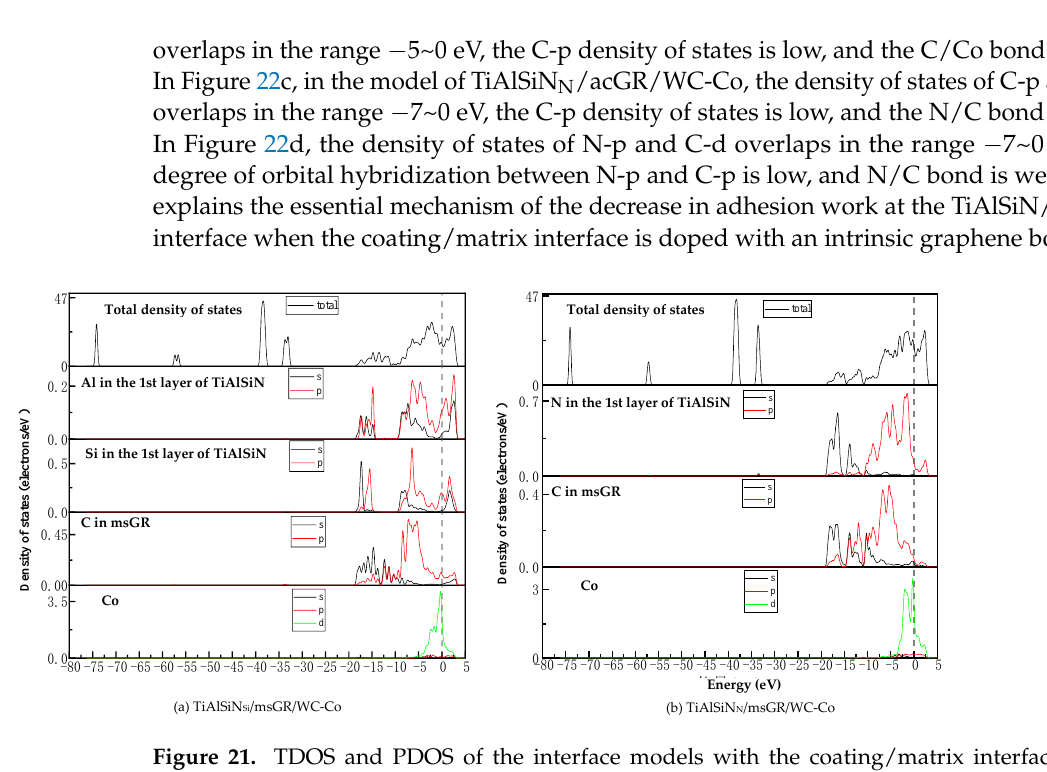
Figure 21. TDOS and PDOS of the interface models with the coating/matrix interface doped with msGR.